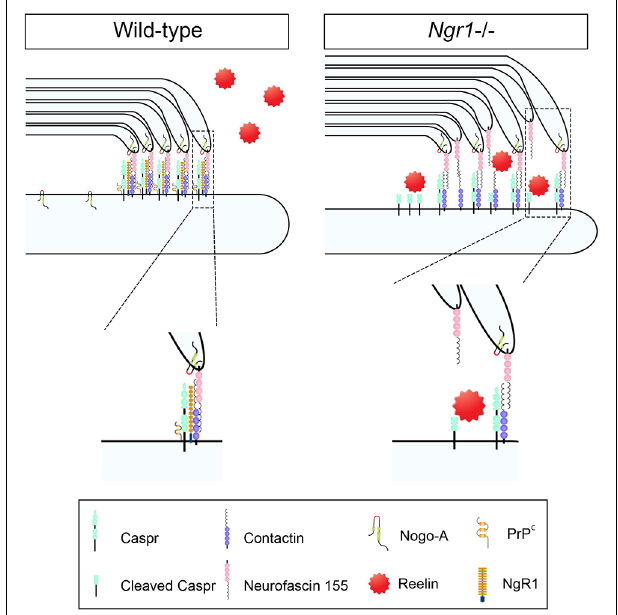
FIGURE 1 | Axo-glial paranodal junctions and a potential regulatory role for Nogo receptor 1 (NgR1): evidence of a disrupted paranode in ngr1 − / − mice. Schematic representation of the proposed unstructured paranodal septate junction in the central nervous system (CNS) myelinated fibers of ngr1 − / − mice. The absence of NgR1 expression in neurons limits the capacity for cellular prion protein (PrPc) and contactin associated protein (Caspr) to interact, leaving Caspr as a substrate for intramembranous cleavage by Reelin. Expedited Caspr cleavage may promote the decompaction of myelin form the paranodal junctions altering the electrophysiological signature and potentially triggering the continuous turnover of myelin (adapted from Coman et al.,